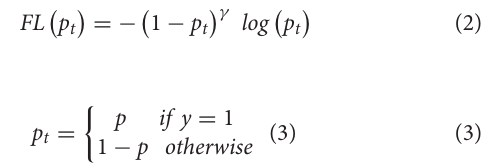
Frontiers in Medicine |